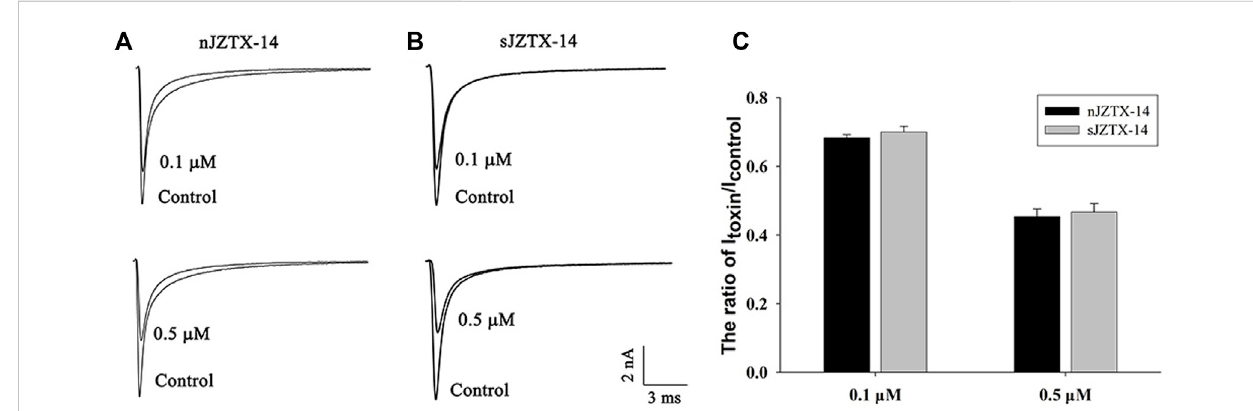
FIGURE 2 ComparisonofsodiumcurrentsinhibitedbynaturalandsyntheticJZTX-14inHEK293TcellsheterologouslyexpressingNav1.5 (A) Currentsinhibited by natural JZTX-14; (B) Currents inhibited by synthetic JZTX-14; (C) Ratio of the remaining sodium currents after toxin